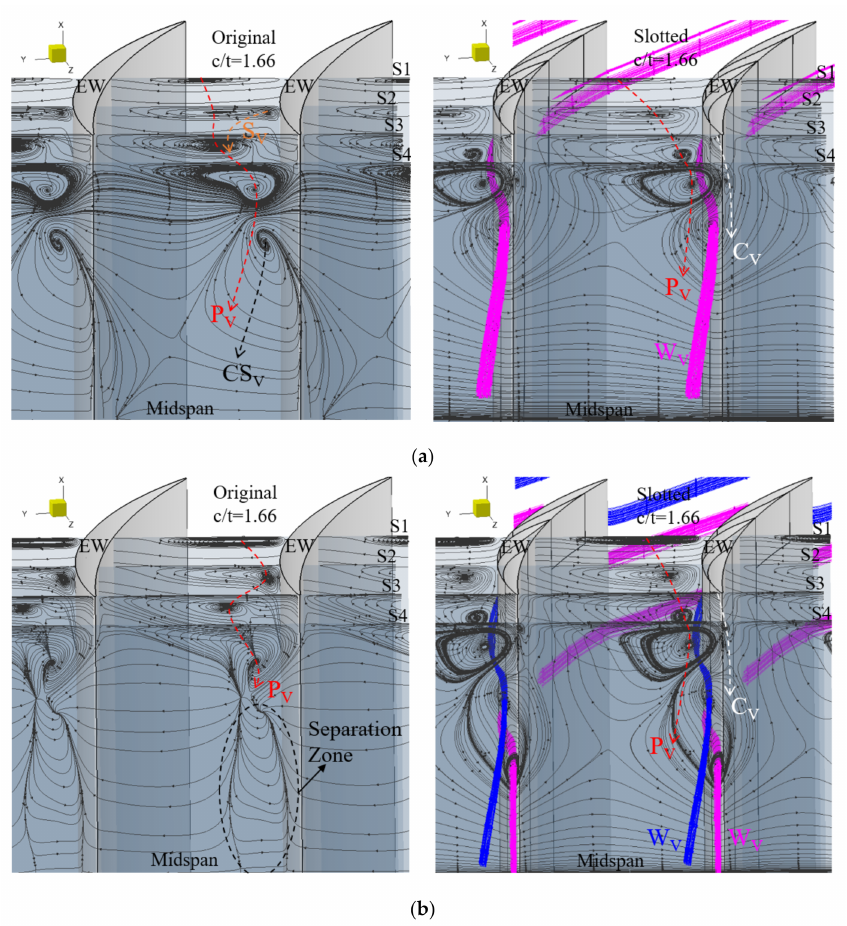
Figure 11. Vortex structures in the flow passages of the original cascade and combined slotted cascade at the solidity of 1.66: ( a ) 0 ◦ ; ( b ) 6 ◦